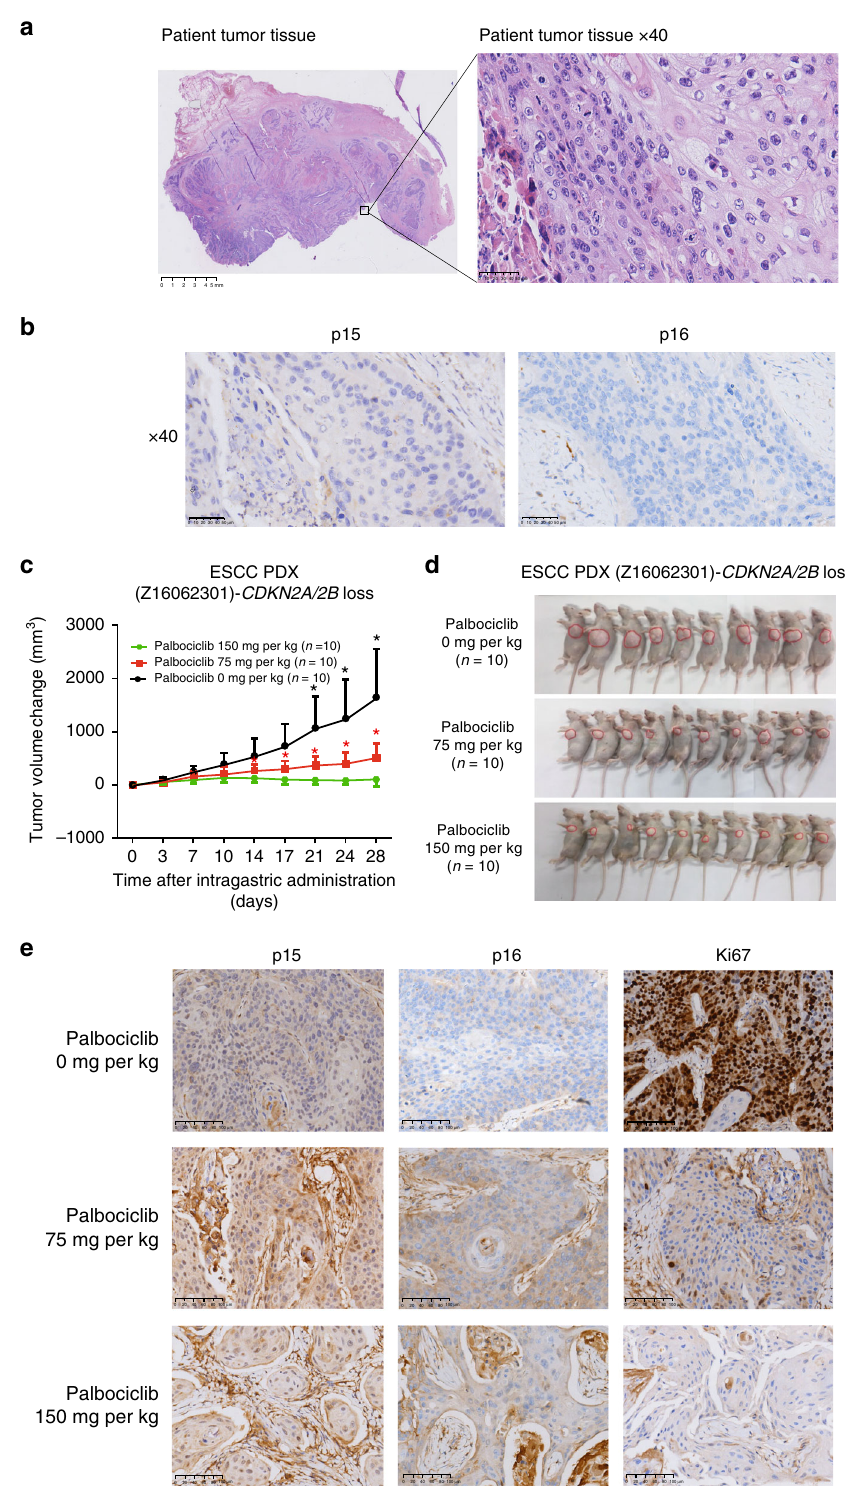
Fig. 6 An ESCC PDX model to con fi rm the biomarkers of drug sensitivity. a Hematoxylin and eosin staining (HE) results of tumor tissue derived from an ESCC patient are shown. Magni fi cation (right) is ×400. b The expression levels of p15 and p16 were detected by immunohistochemistry (IHC) staining in the FFPE tumor tissues of this ESCC patient. Magni fi cation (right) is ×400. c Change in tumor volume following treatment with palbociclib in three doses in patient-derived xenografts (PDXs)-Z16062301 (28 days) (mean ± s.e.m., n = 10). Error bars correspond to standard error of the mean of tumor volume. * p < 0.01, Student ’ s t test, palbociclib 0 mg/kg compared with palbociclib 75 mg/kg; * p < 0.01, Student ’ s t test, palbociclib 75 mg/kg compared with palbociclib 150 mg/kg. d General picture of PDXs-Z16062301 after intragastric administration. e IHC staining of FFPE tumor tissue from PDXs treated with different dosages of palbociclib was used to detect the expression of p15, p16, and Ki67. The imaging results of IHC staining with the magni fi cation of ×200 are